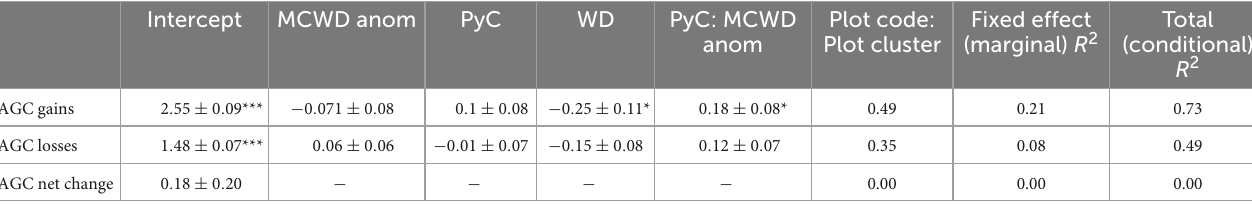
TABLE 1 Parameter estimates for the selected models explaining AGC (gains, losses, and net change) during severe droughts ( σ ≤ − 1.65). Intercept MCWD